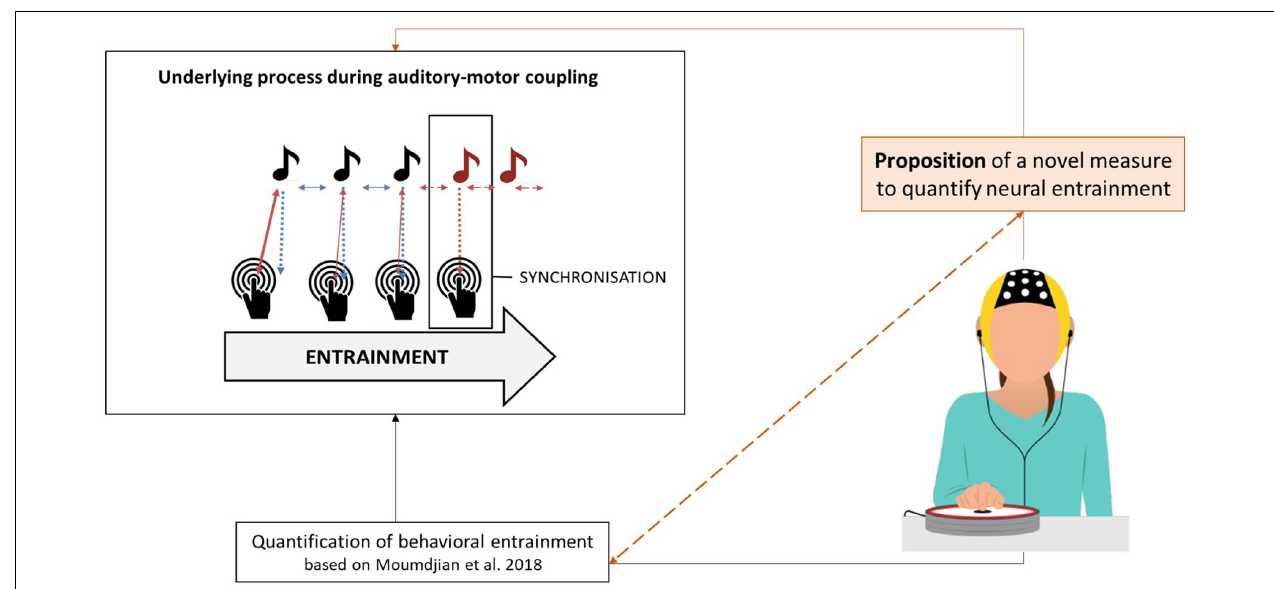
FIGURE 1 | Graphical illustration of the study’s rationale and the proposed contribution to the current state of the